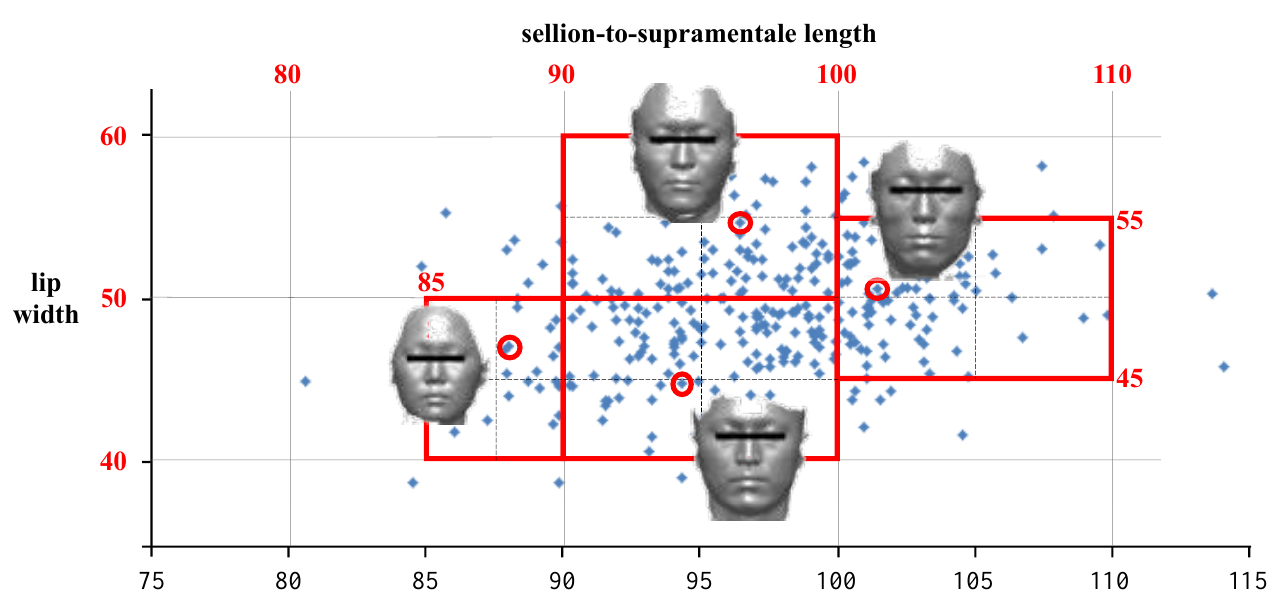
Figure 5. Representative face models for the proposed pilot oxygen mask sizing system of KAF pilots.